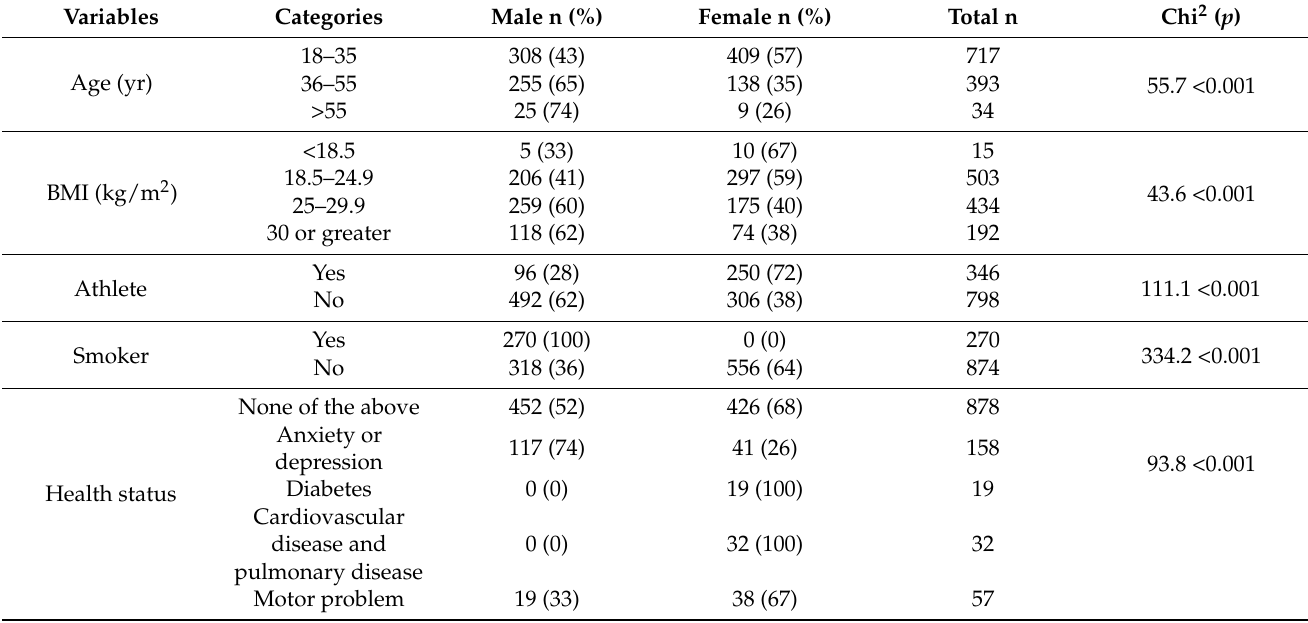
Table 2. Description of the sample (n = 1144; female: n = 556, male: n = 588) regarding demography, anthropometry and health status depending on